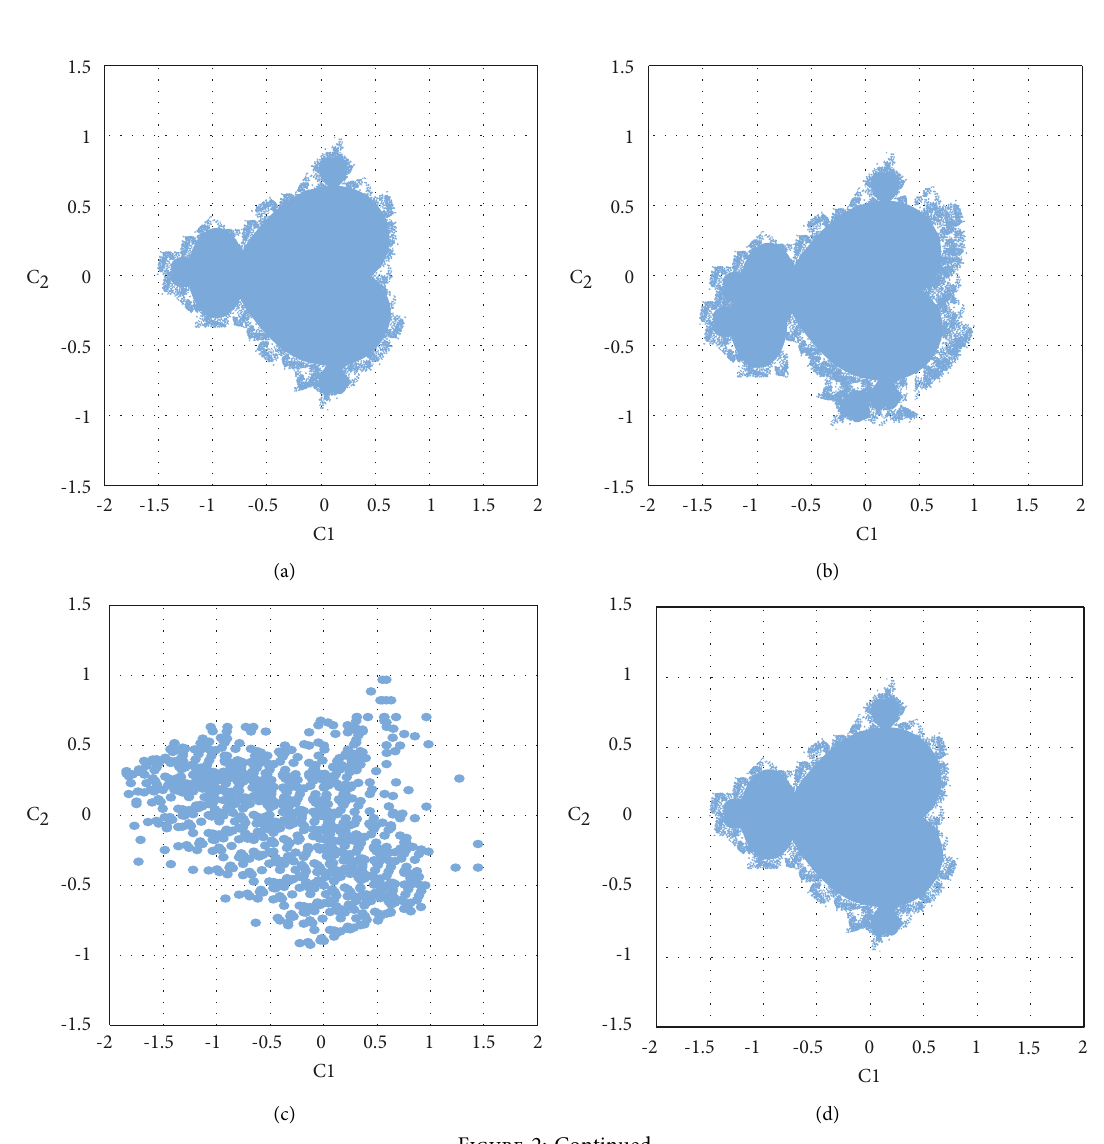
Figure 1: Mandelbrot set M ( f ) for noise-free mapping